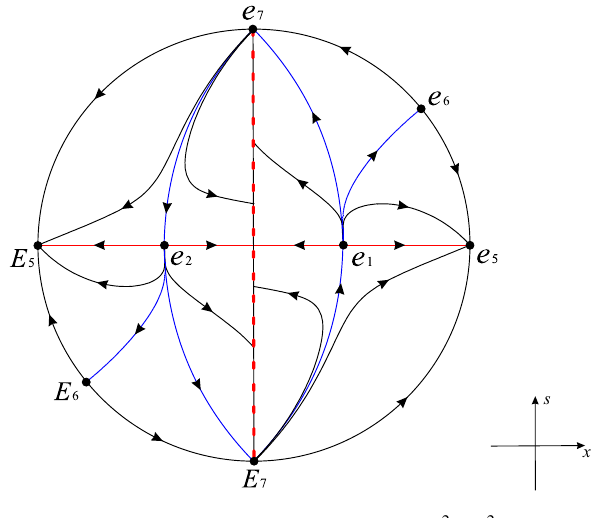
Fig. 3 The phase portrait of the invariant surface x 2 − z 2 = 1 Table 3 Equilibrium points and their characteristics on the invariant plane x 2 − z 2 = 1 for all s ∈ R Equilibrium